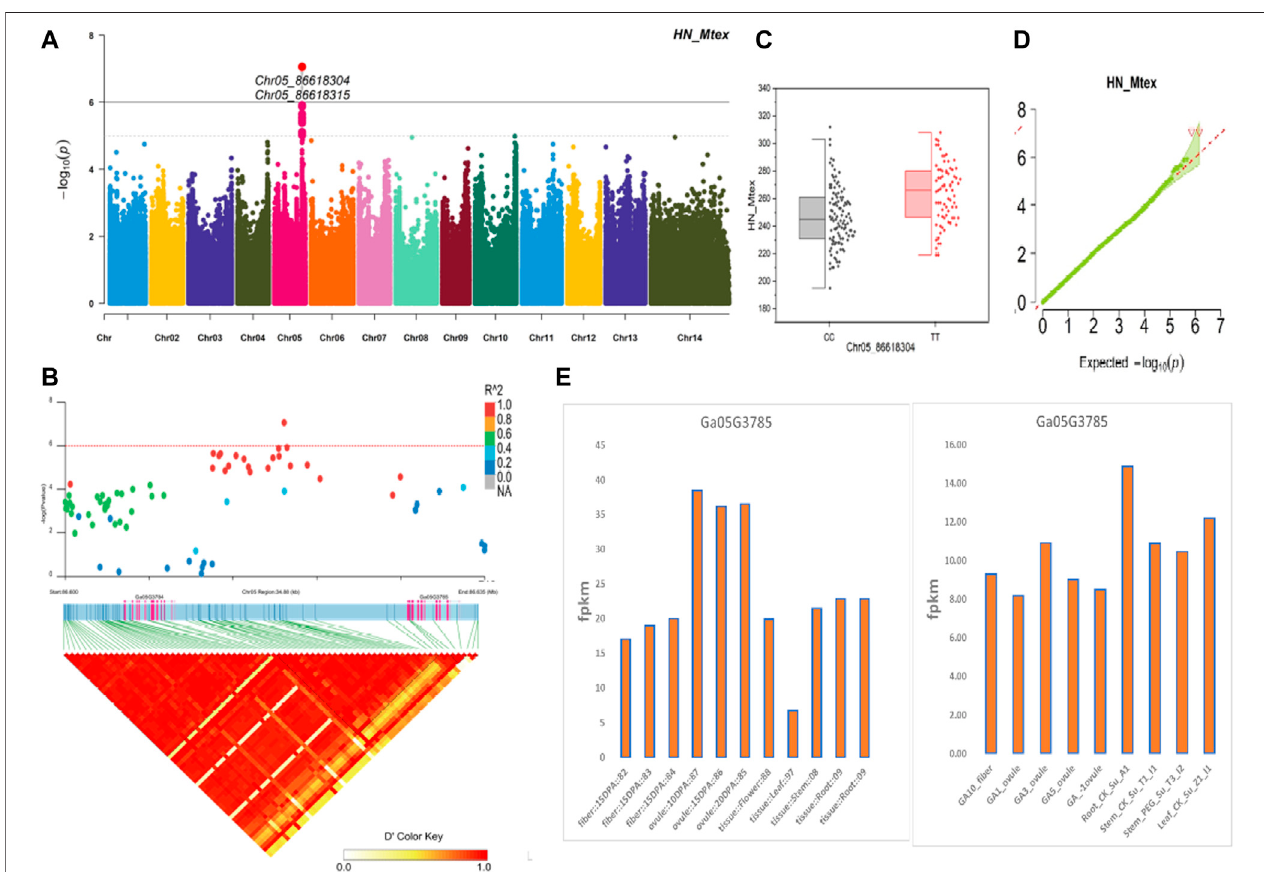
FIGURE7| Genome-wideassociationstudiesforFinenessin G.arboreum (A) ManhattanplotsforFinenessrelatedtraitHN_Mtex;dotted-horizontallinedescribes signi fi cance threshold value kept at [ − log ( p ) > 6] (B) GWAS-LD block displaying haplotype region (34.88 kb) surrounding the displaying peak on chromosome Chr05 associatedwithFinenessrelatedtraitsalongwithGWASregionalplotrevealingkeySNPsandnearbygene(s)intheregion (C) Quantile-QuantileplotsforFinenessrelated traits (D) Box plots presenting differences for Fineness related traits among two favorable haplotypes of SNP Chr05_86618304:HN_Mtex (E) Expression levels of representative annotated gene Ga05G3785 at different developmental stages of G . arboreum from two different sources.